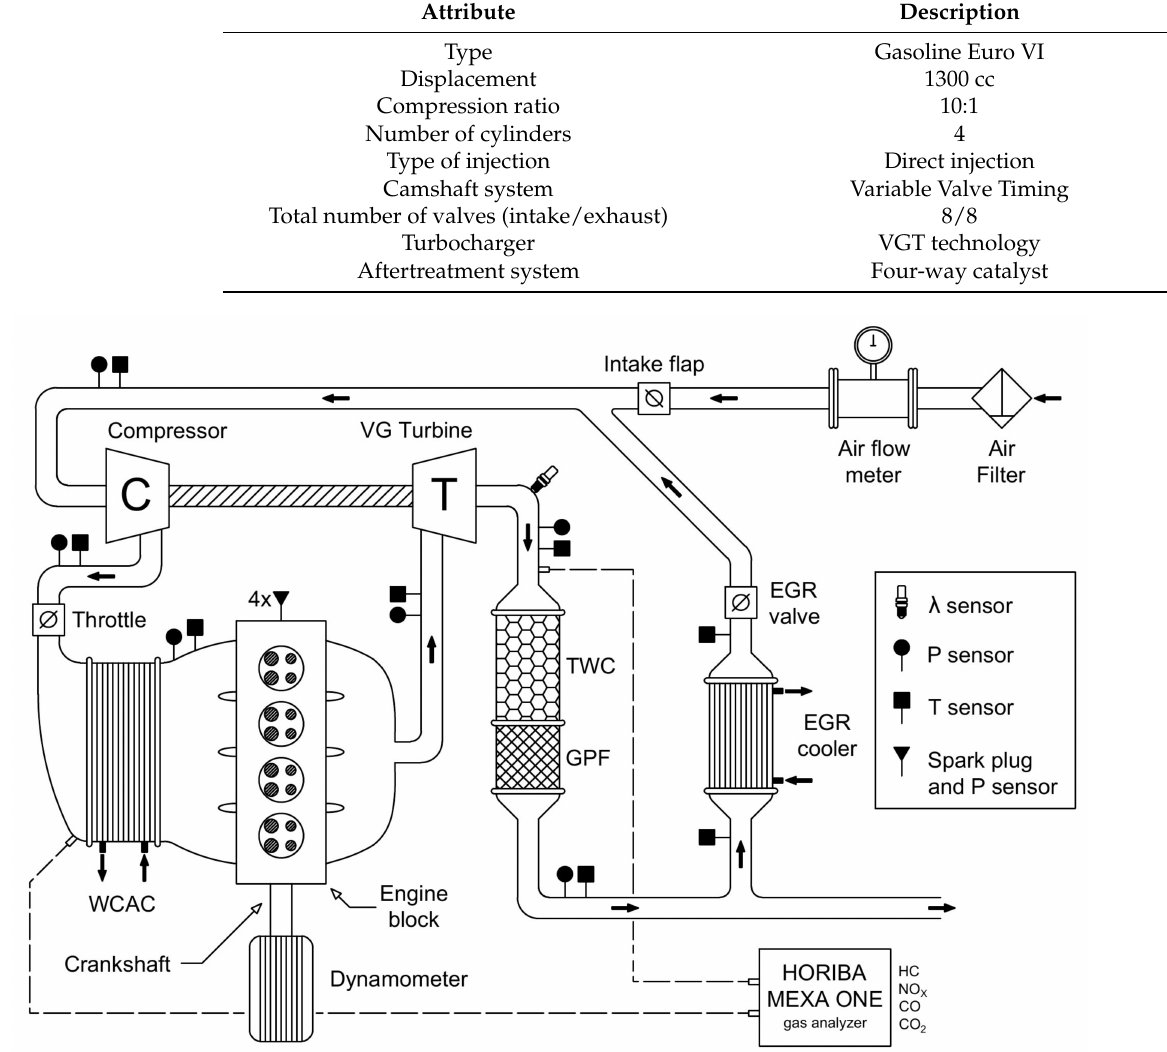
Figure 1. Schematic engine